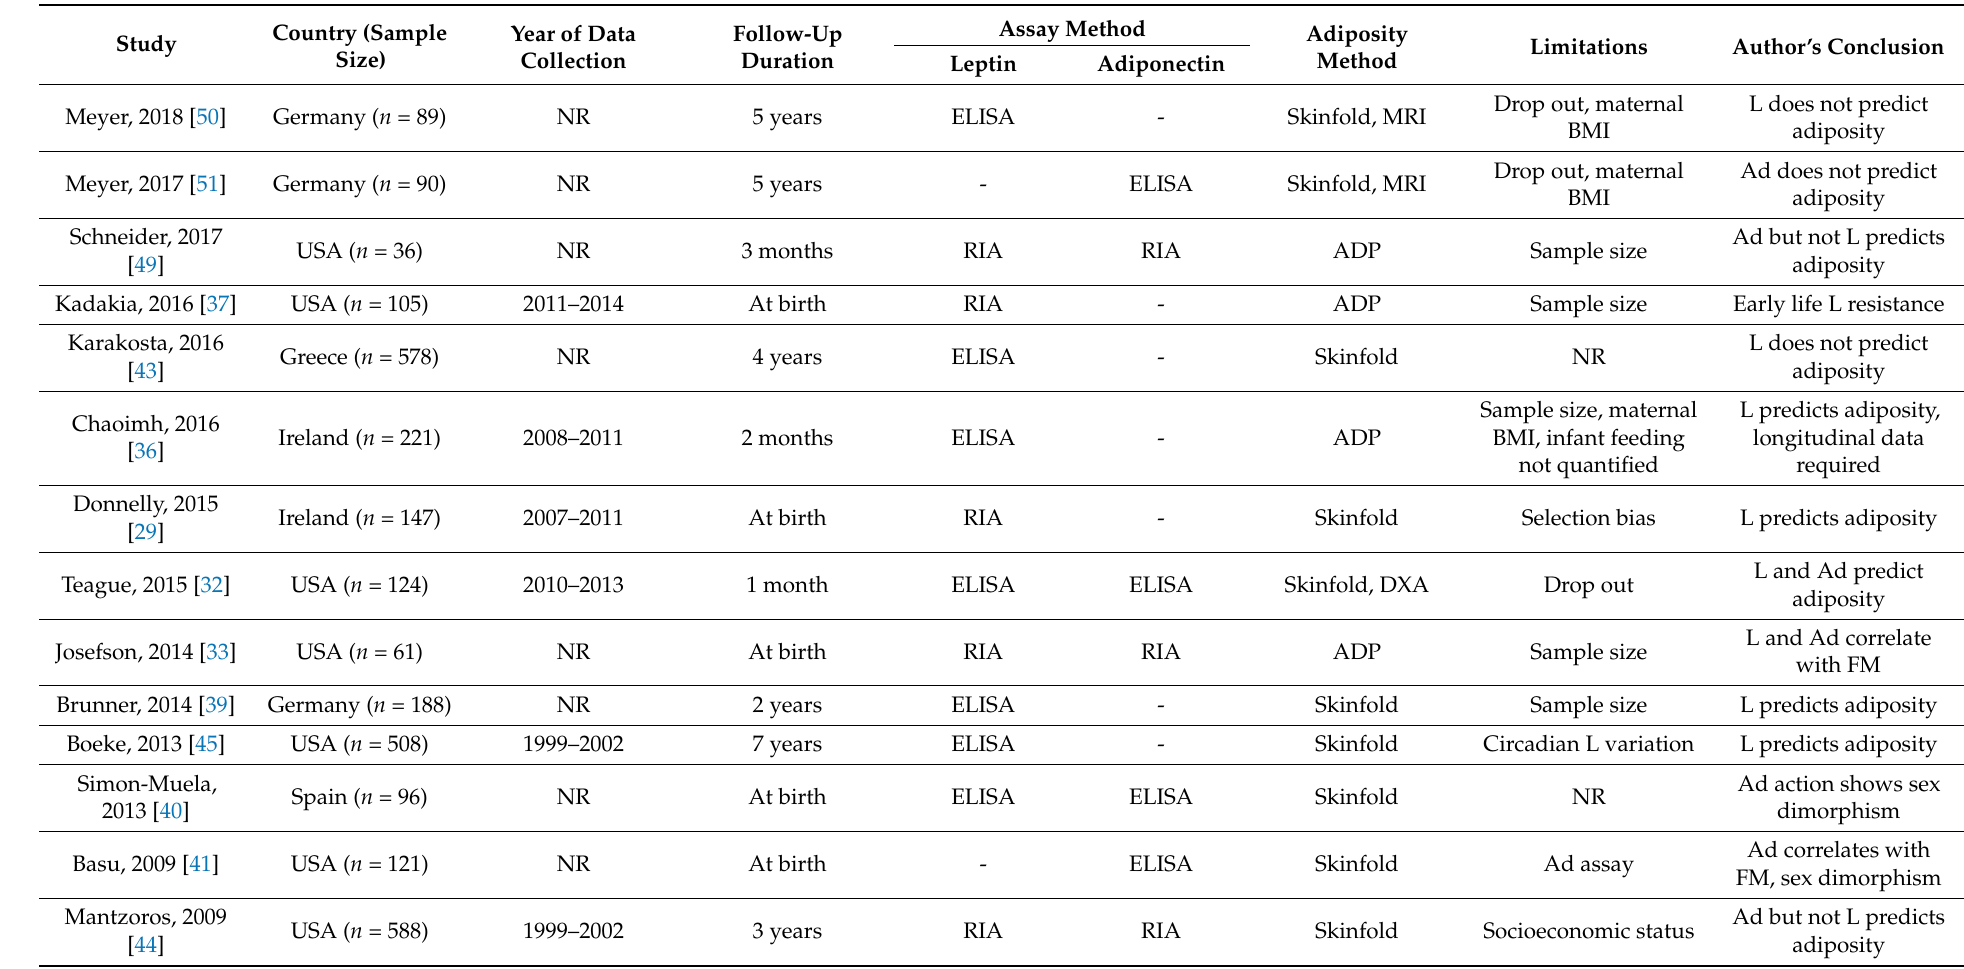
Table 1. Characteristics of the studies